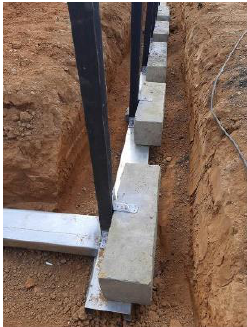
Figure 6. Construction of the structural foundation.